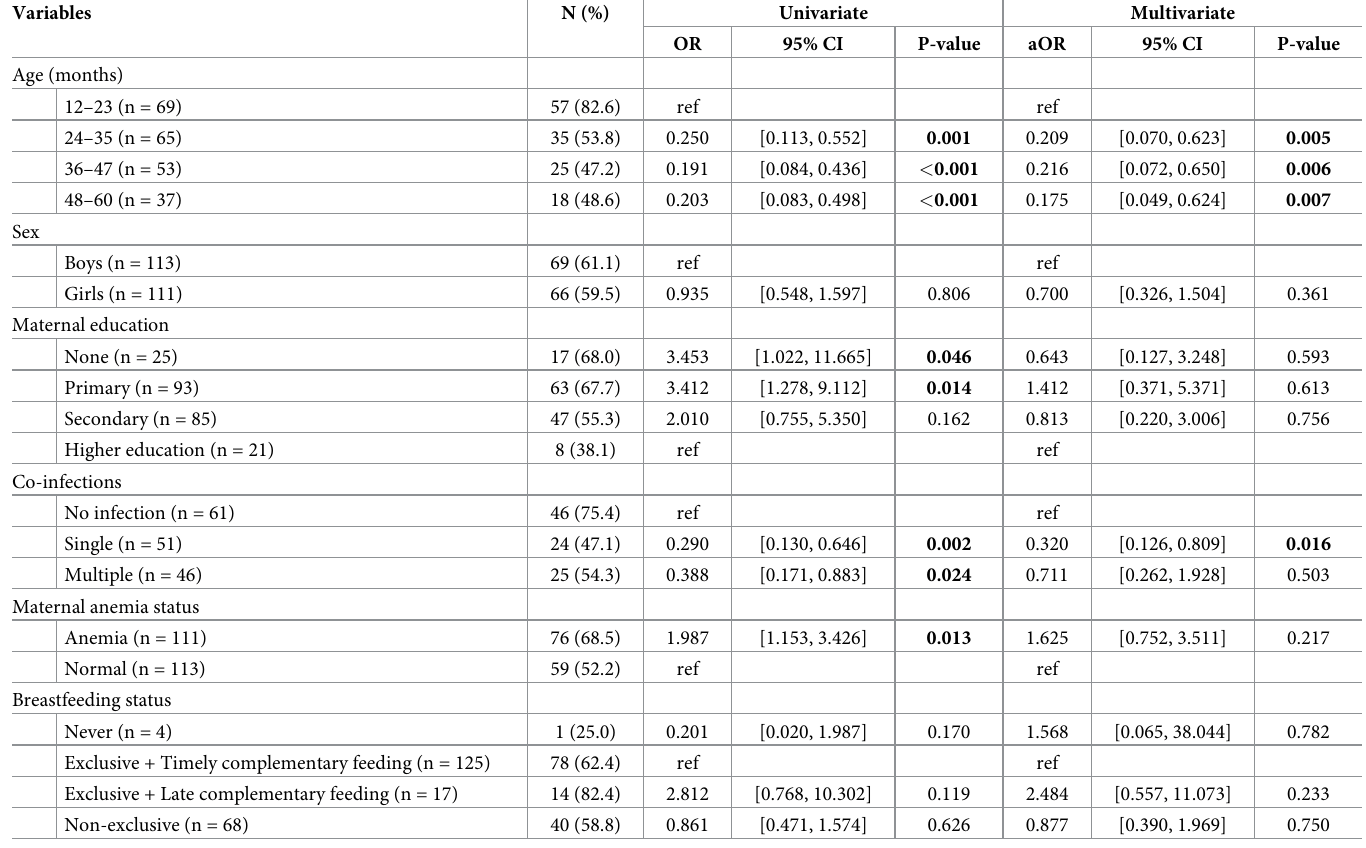
Table 6. Factors associated with anemia among preschool-age children (PSC) in this study (n = 224).